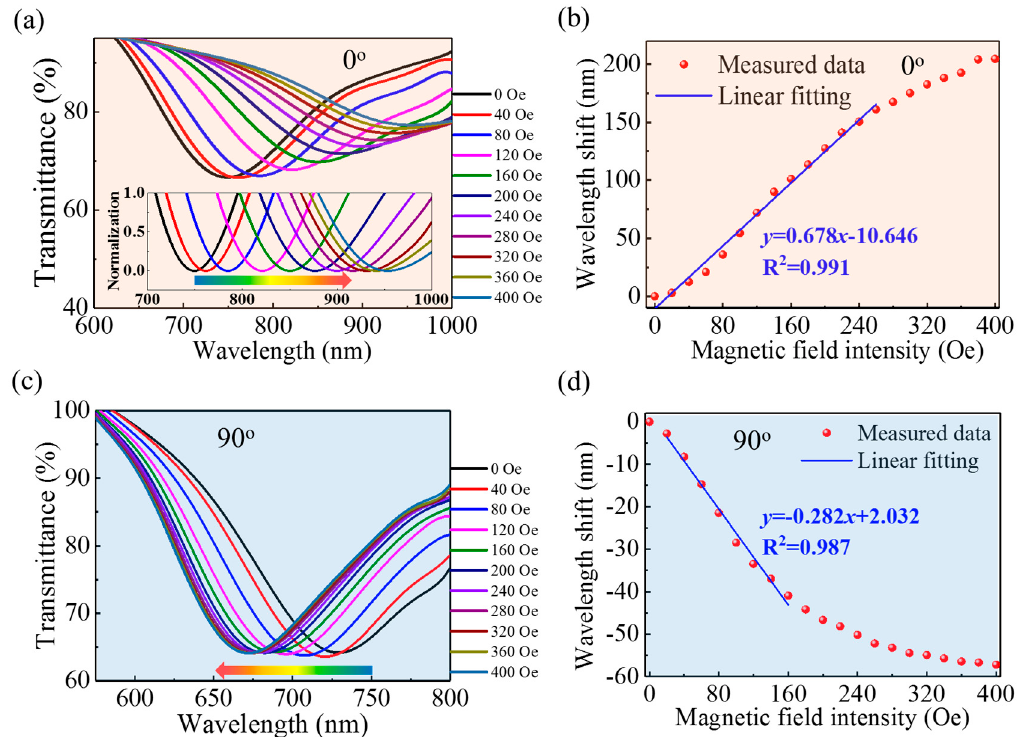
Figure 9. ( a , c ) Spectra for different magnetic-field intensities and ( b , d ) corresponding resonance wavelength as a function of magnetic-field intensity. Panels (a,b) correspond to the orientation angle of 0°, and panels (c,d) correspond to the orientation angle of 90°. The inset in (a) shows the normalized transmittance spectra near the resonance wavelengths.